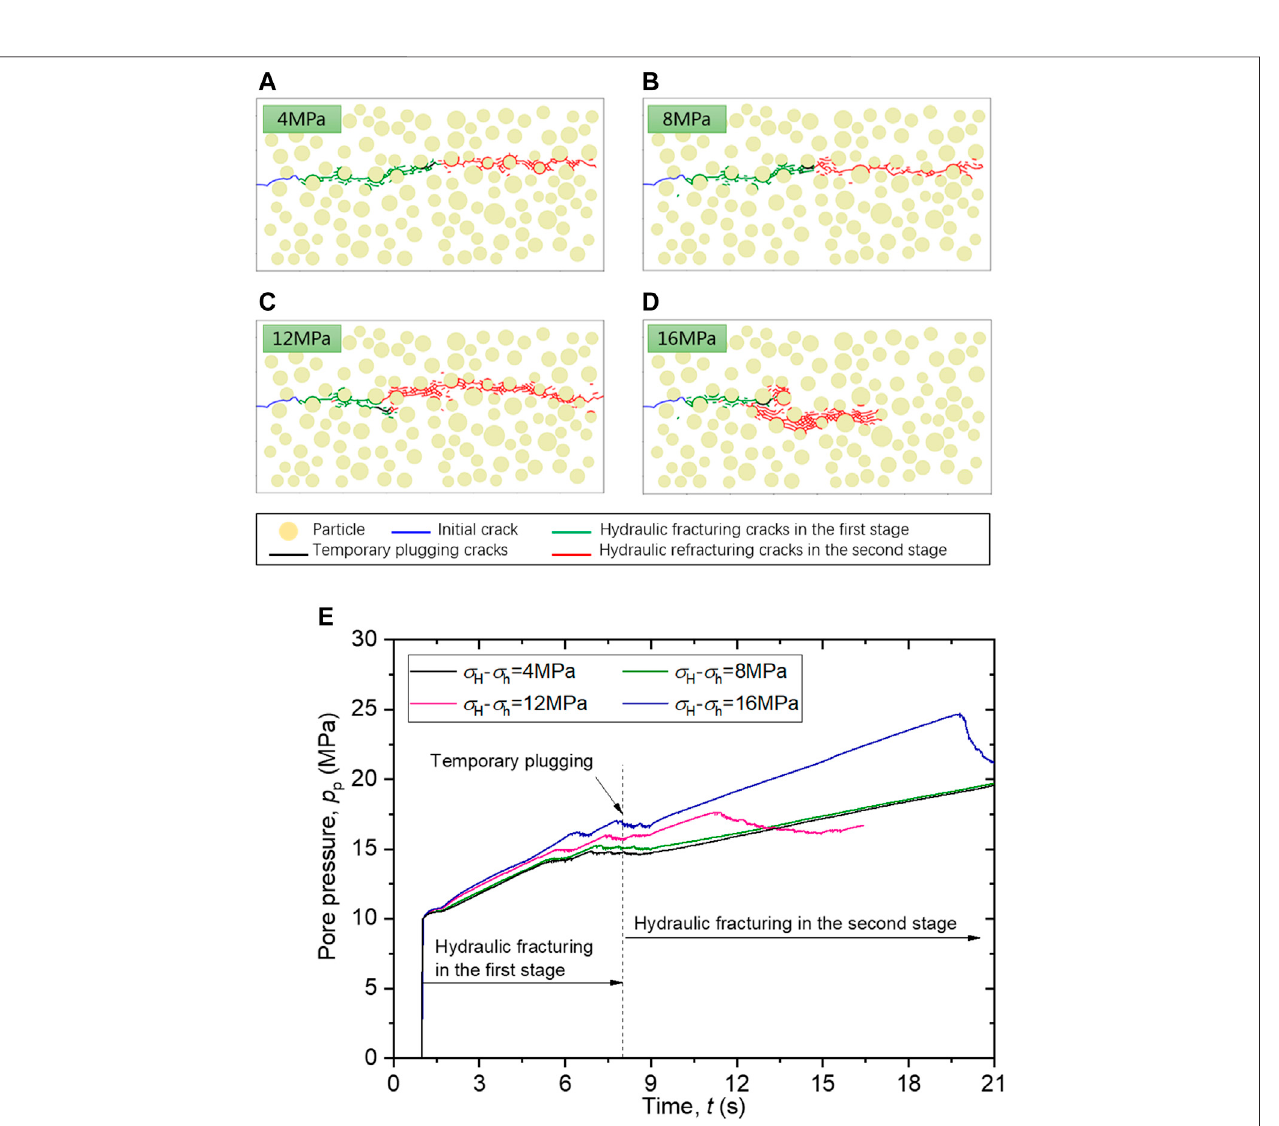
FIGURE 3 | (A,B,C,D) Fracture evolution characteristics of temporary plugging-refracturing under different in-situ stress differences; (E) Pore pressure history curve at injection point under different horizontal stress difference.